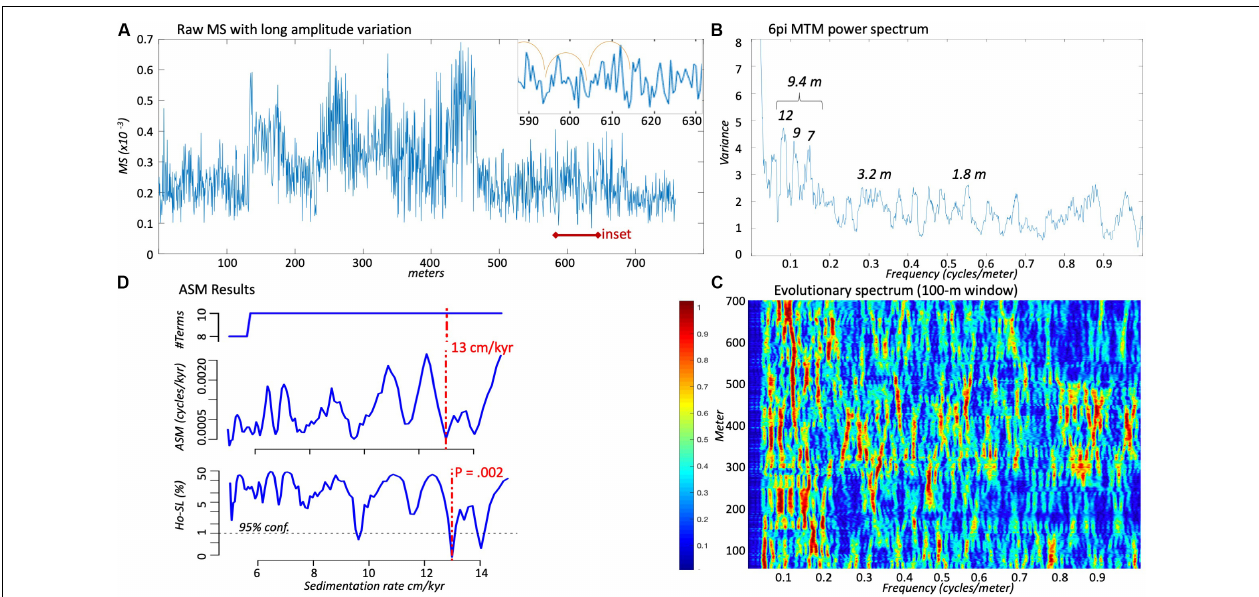
FIGURE 6 | Results from time series analysis and modeling for MS data collected in outcrop from the mid-upper Salagou Formation (see stratigraphic context in Figure 3 ; lower bar). The section is measured in meters (from low to high is moving up-section). (A) Magnetic susceptibility data with long-term amplitude variation ( ∼ 100–130 m cycles). Higher frequency signals are not notable at this scale, but the inset zooms into an interval (590–630 m) to provide an example of the 10 m cycles (interpreted with orange arcs) that are also present in this section. (B) The power spectrum shows the proportion of power (or variance) as a function of frequency (in cycles/m). (C) The FFT spectrogram, computed with a 100 m running window and subtraction of low pass Taner filter with a cutoff frequency of 0.035 cycles/m (see Supplementary Appendix S1 for script). Warmer (red) colors represent high power and cooler (blue) colors low power. (D) Results of ASM analysis with the optimal sedimentation rate identified by the vertical red dashed curve. Top : number of astronomical frequencies used in the fit; middle: ASM statistic; bottom : statistical significance of Monte Carlo modeling with the critical level shown by the horizontal black dashed